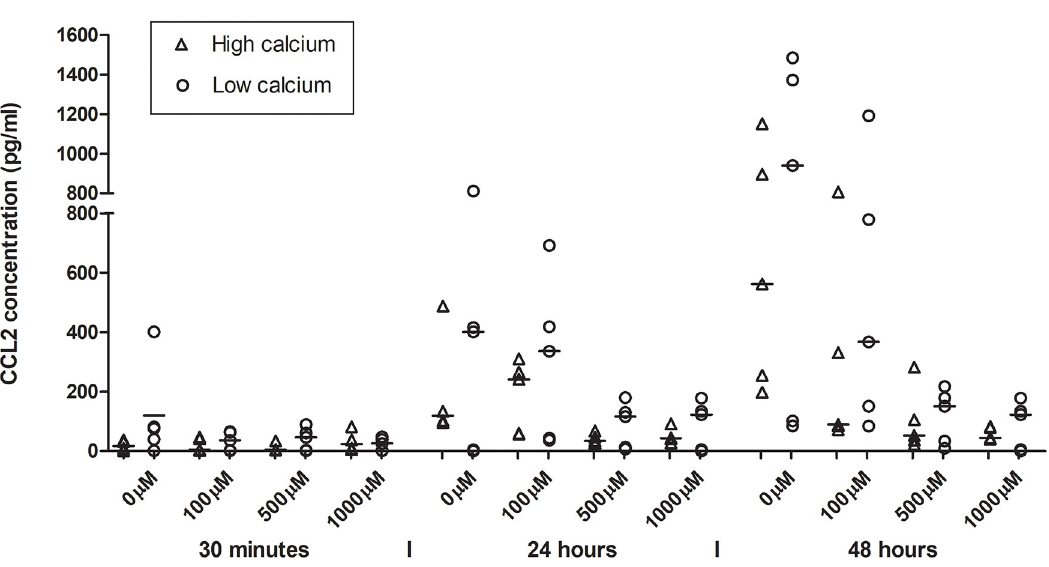
on keratinocytes. 2